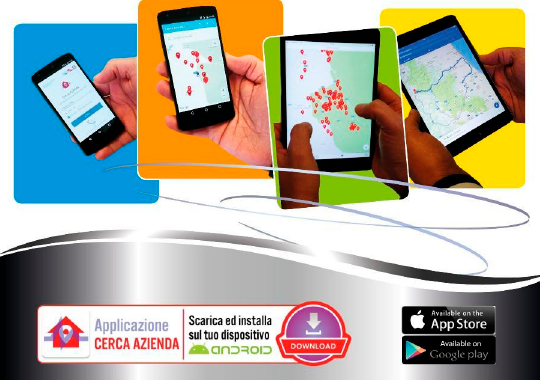
Figure 5. Mobile application called “Search the Farm”, Source: Istituto Zooprofilattico Sperimentale dell’Abruzzo e del Molise “G. Caporale”.